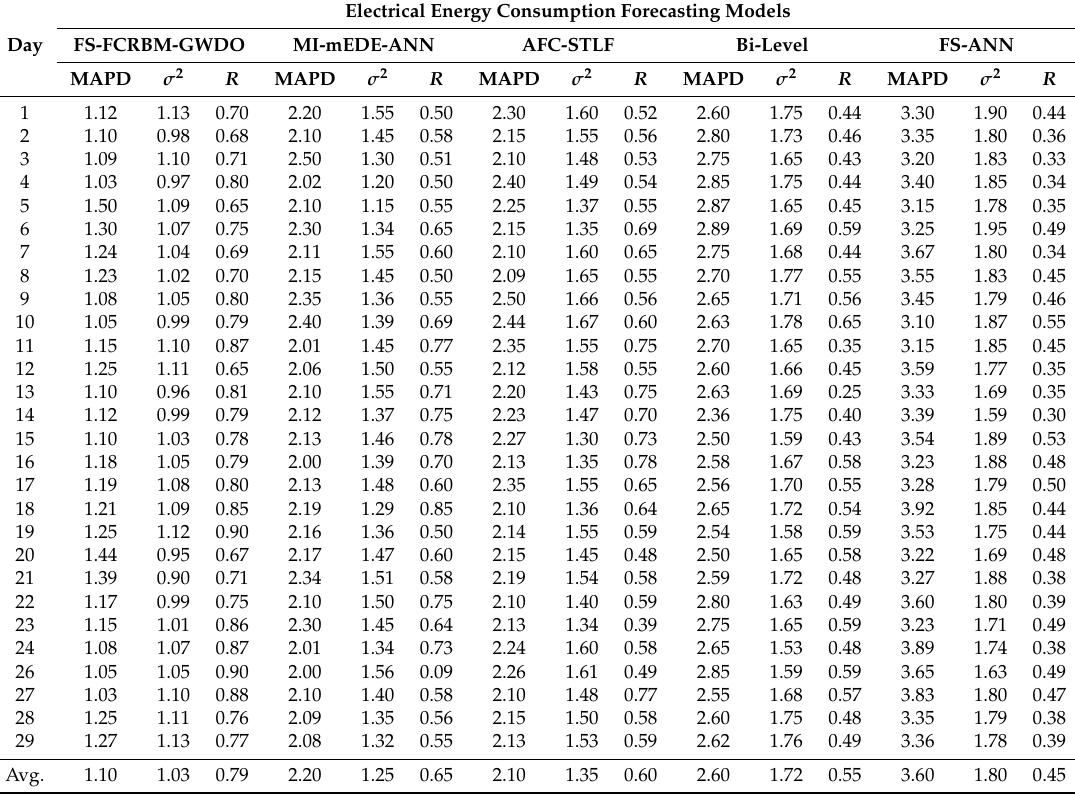
Table 3. FE power grid February results of leap year 2016: comparative performance evaluation of the proposed and existing models in terms of MAPD, variance, and correlation